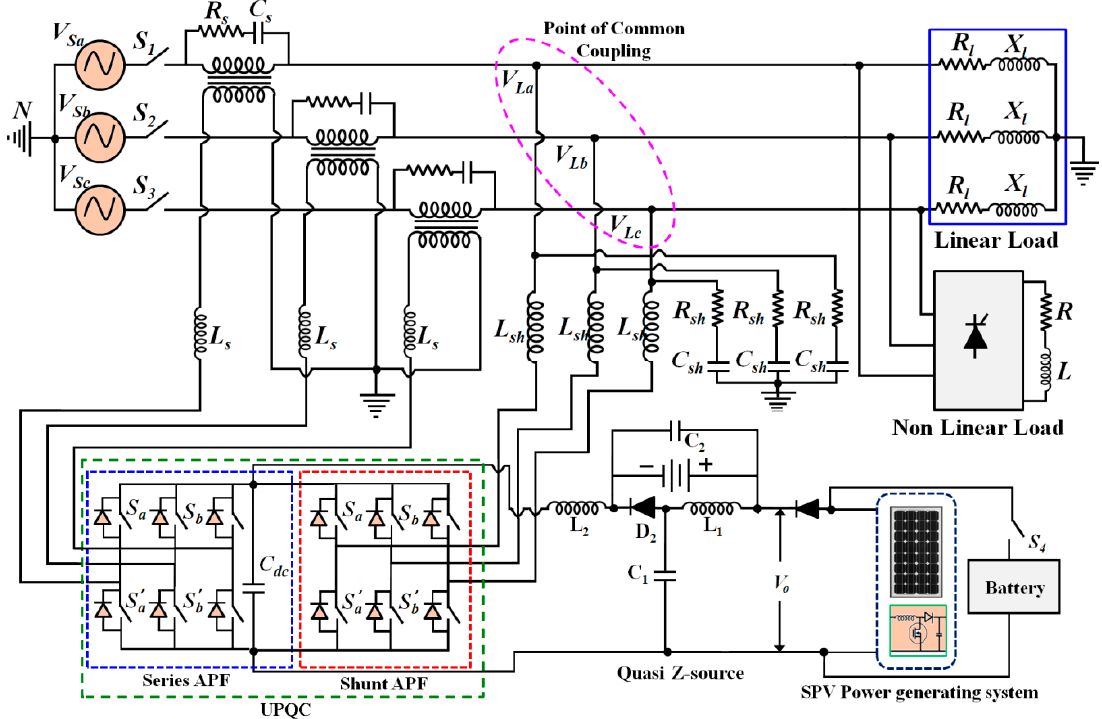
Figure 1. Proposed solar photovoltaic-supported unified power quality conditioner topology.